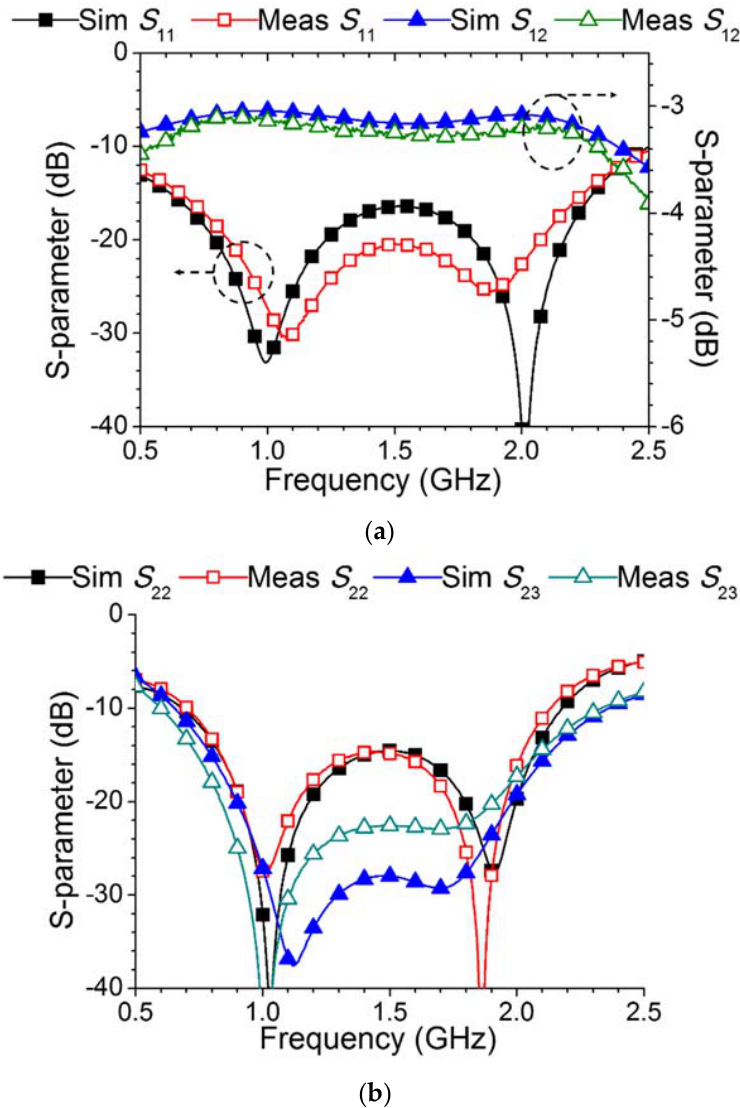
Figure 8. Measured and simulated ( a ) S 11 , S 12 , ( b ) S 22 , and S 23 of the fabricated prototype.